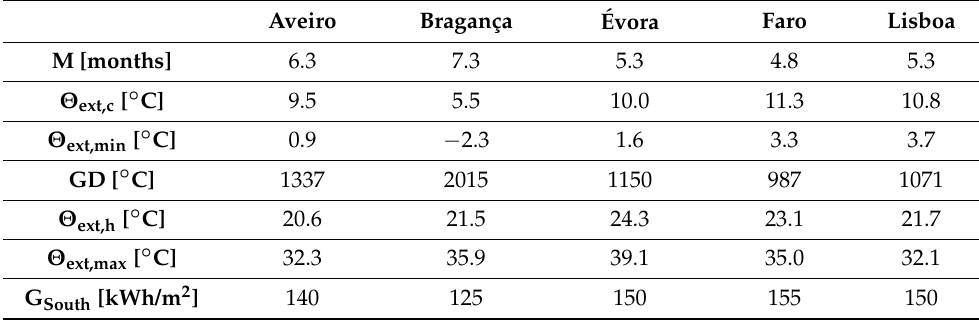
Table 1. External weather characteristics of the climates considered in the dynamic simulations.